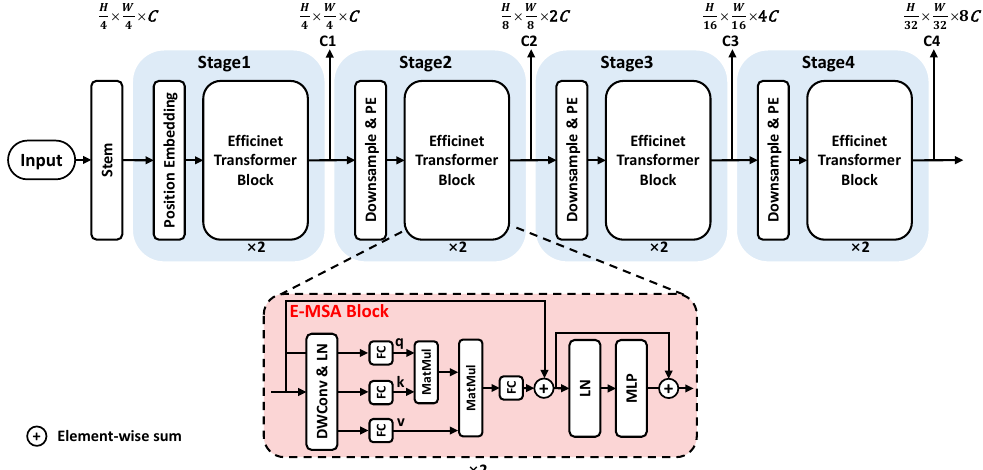
Figure 5. The overall framework of the Efficient transformer